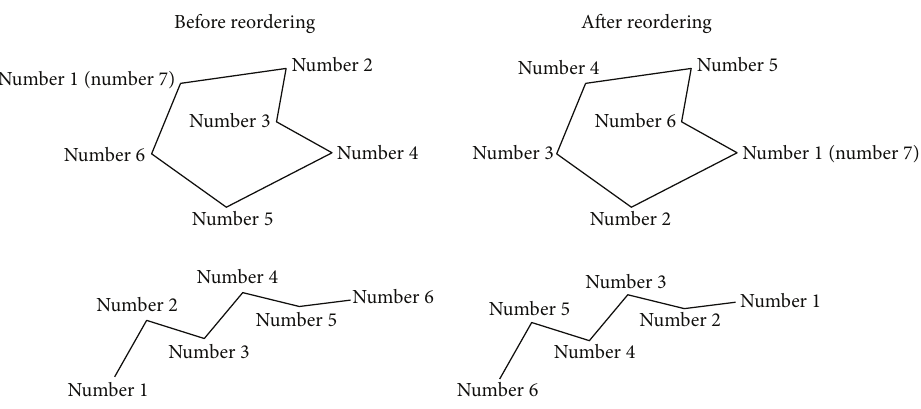
Figure 3: Examples of vertex reordering attack.